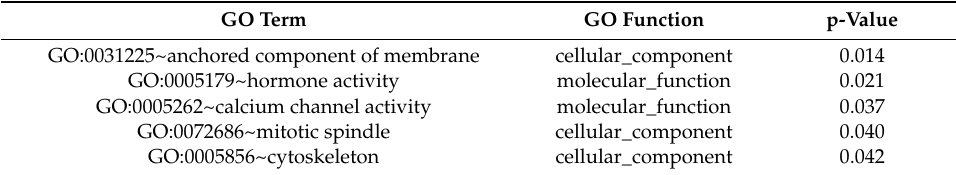
Table 3. Co-enriched GO terms of DE lncRNA and mRNA.